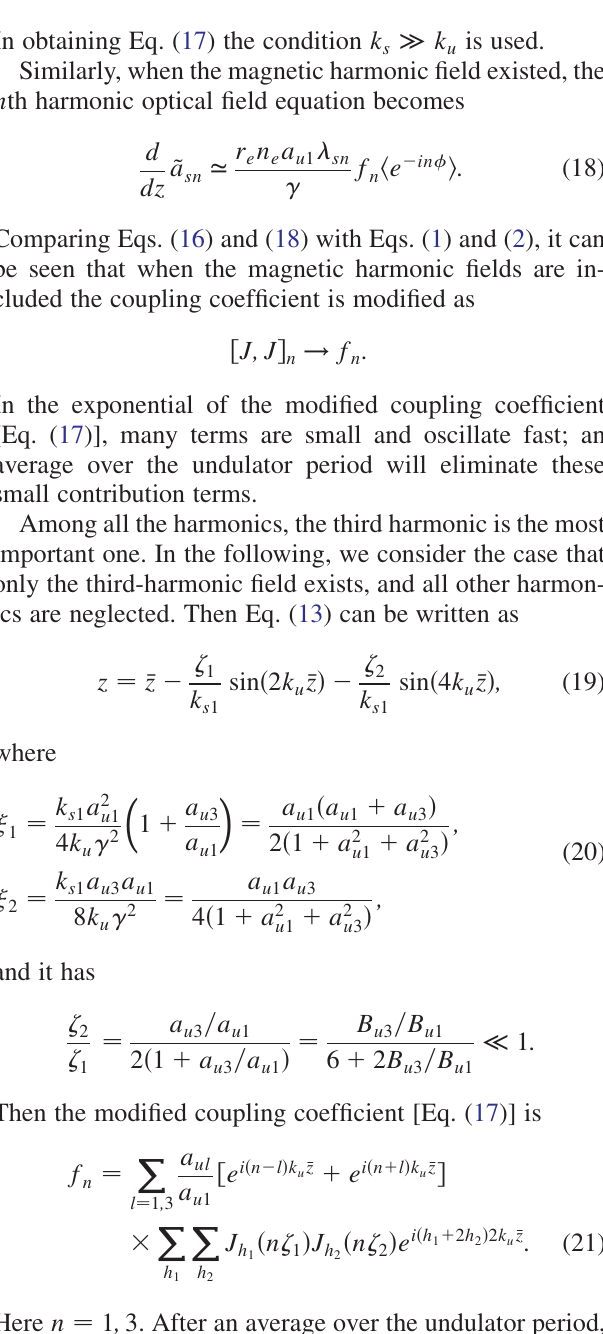
FIG. 1. Modified third-harmonic coupling coefficient due to the harmonic magnetic